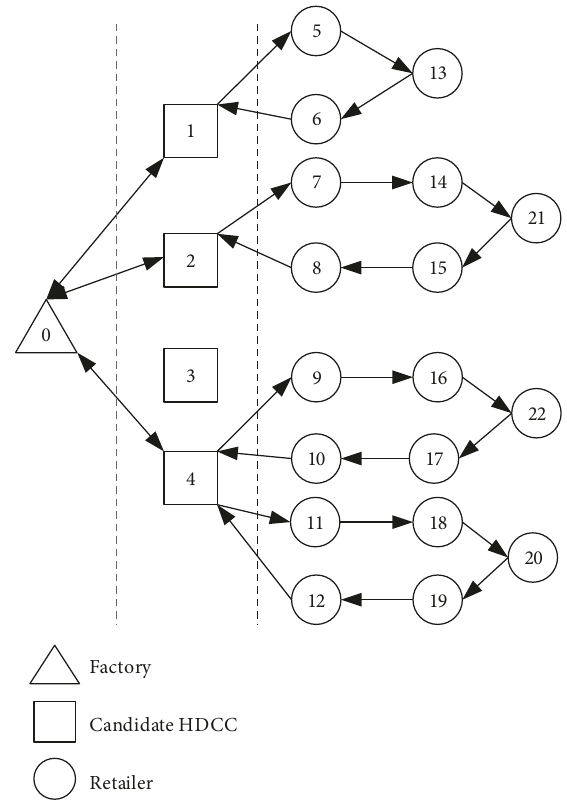
Figure 1: A closed-loop supply chain